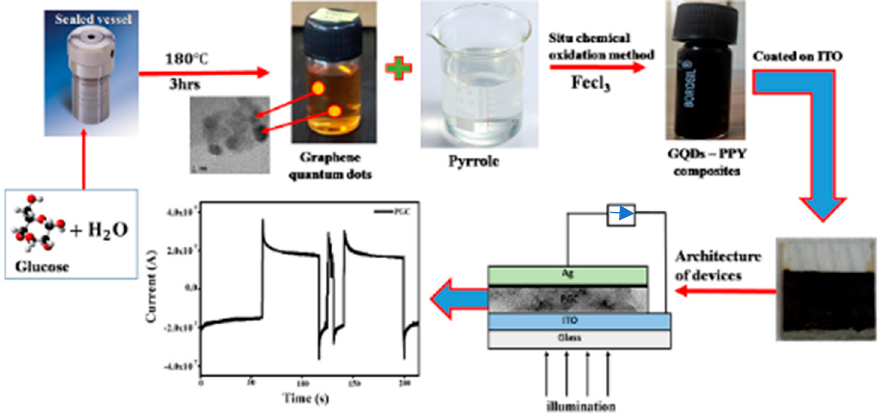
Scheme 1. Schematic diagram of the synthesis of PPy ‐ GQDs composites and fabrication of a single ‐ layer